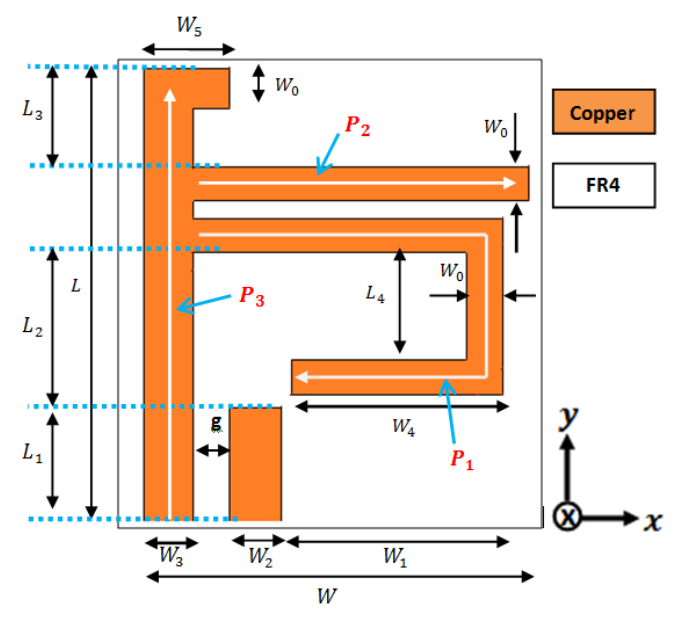
Figure 1: Geometry of the proposed ACS-fed tri-band an- tenna